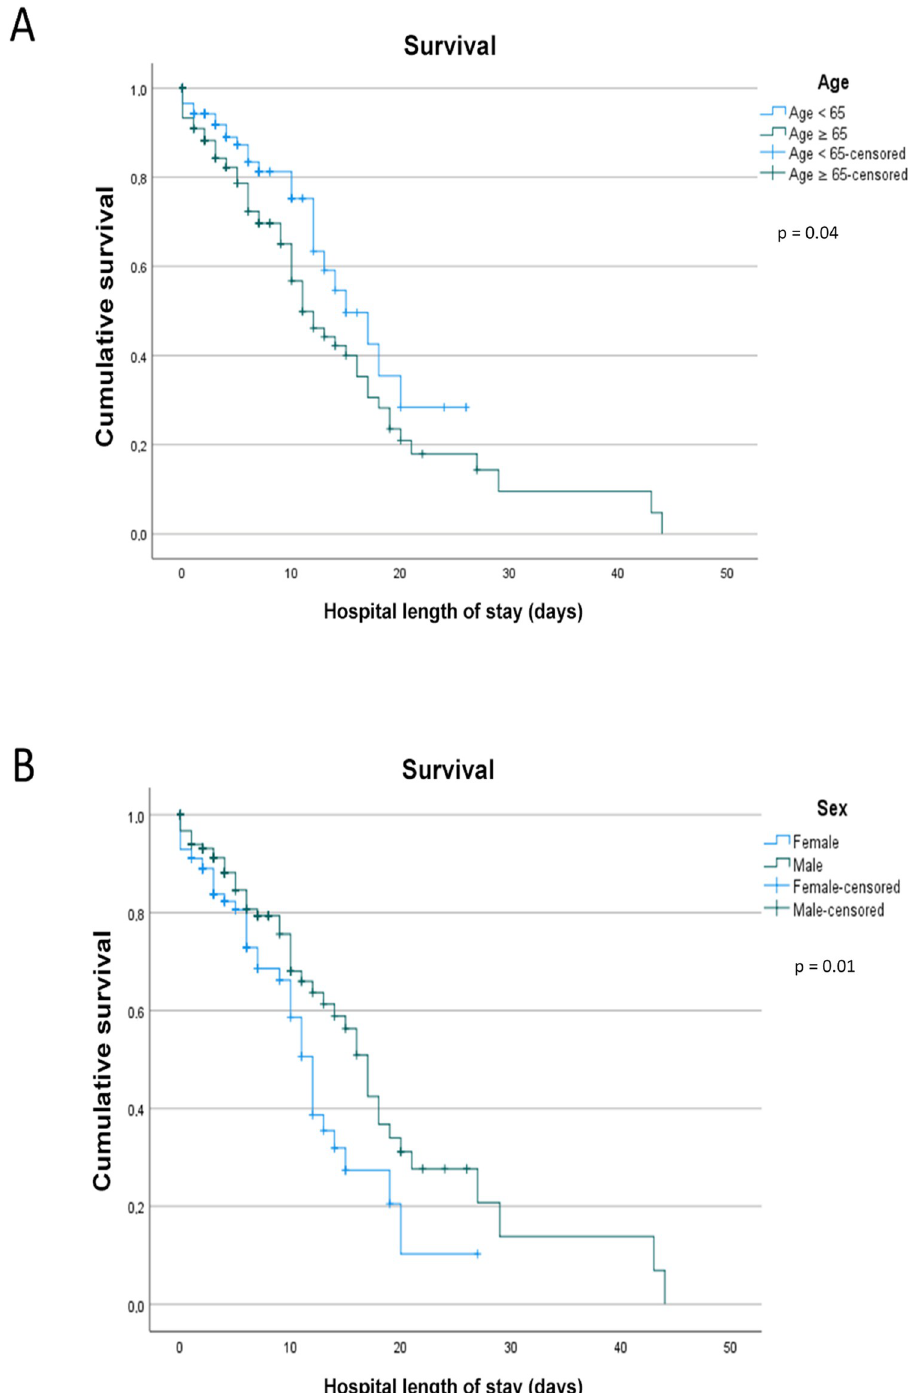
Fig 1. Survival analysis by (a) age and hospital length of stay and (b) sex and hospital length of stay.